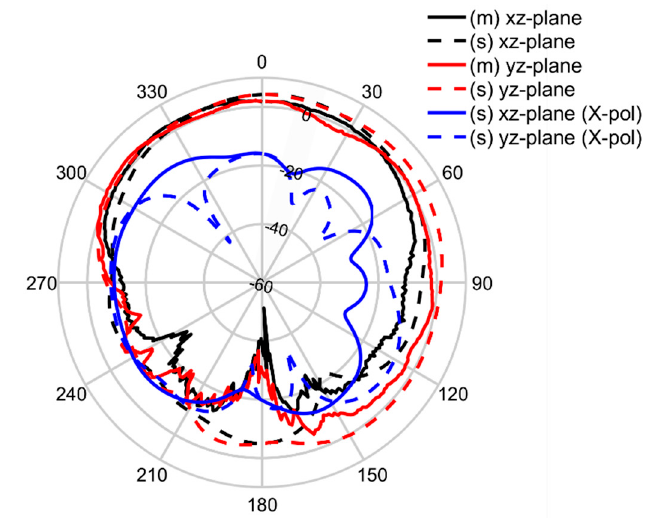
Figure 6. Simulated and measured radiation patterns at 24.125 GHz.